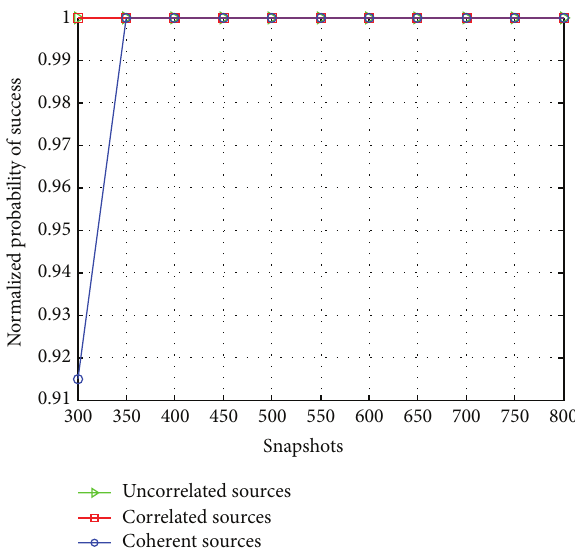
Figure 7: NPS of the proposed method versus input SNR for the uncorrelated, correlated, and coherent signals.